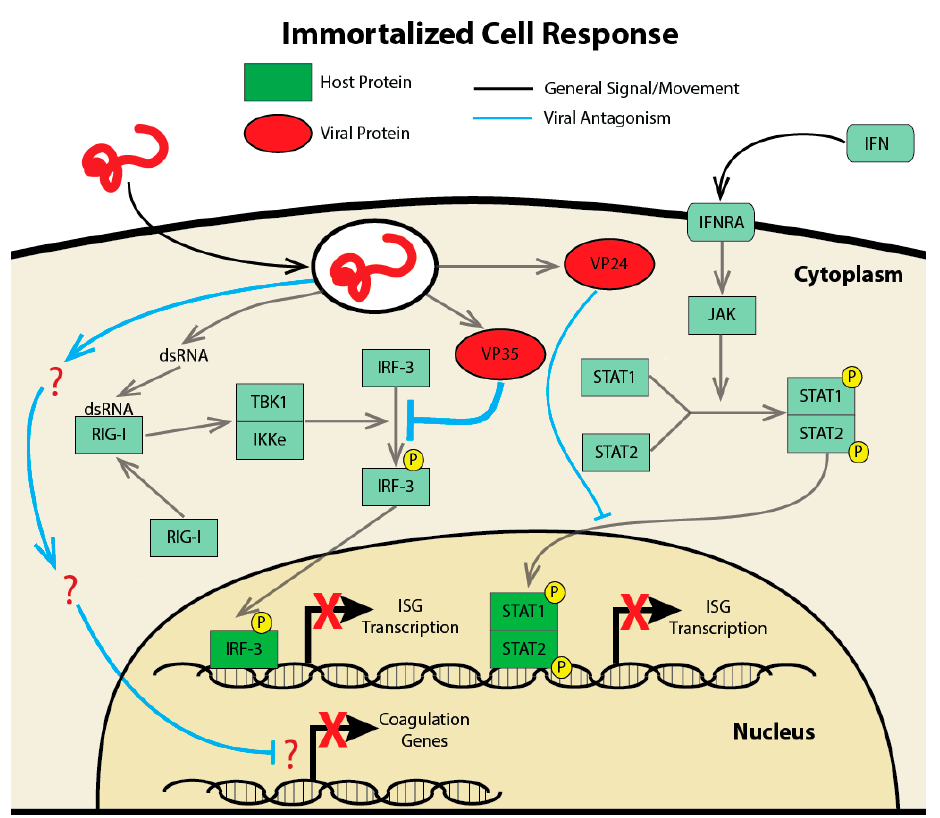
Figure 1. Suppression of the transcriptional response to EBOV infection in immortalized cell